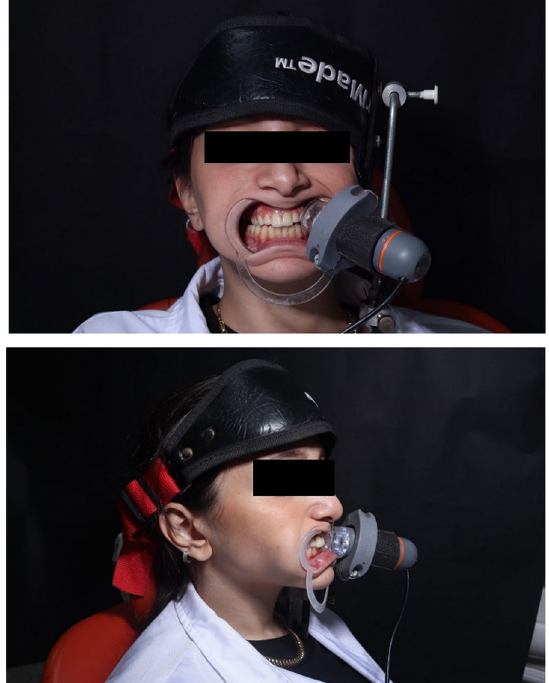
Fig. 6 MHD positioning the microscope to detect the buccal crown margin